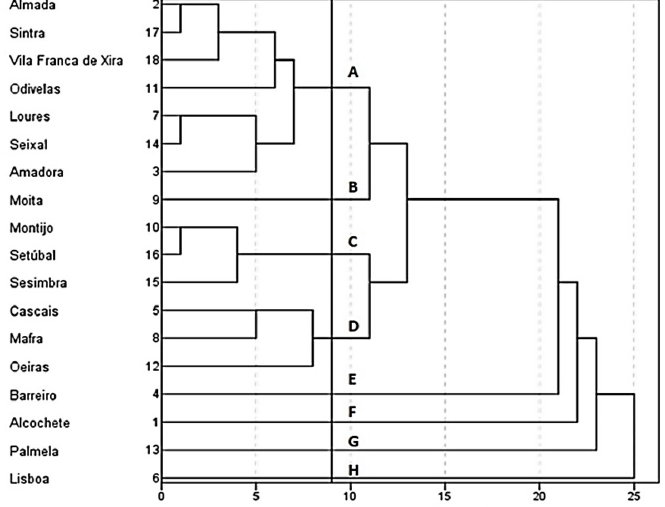
Figure 5. Cluster analysis dendrogram (cut-off line at distance 9).